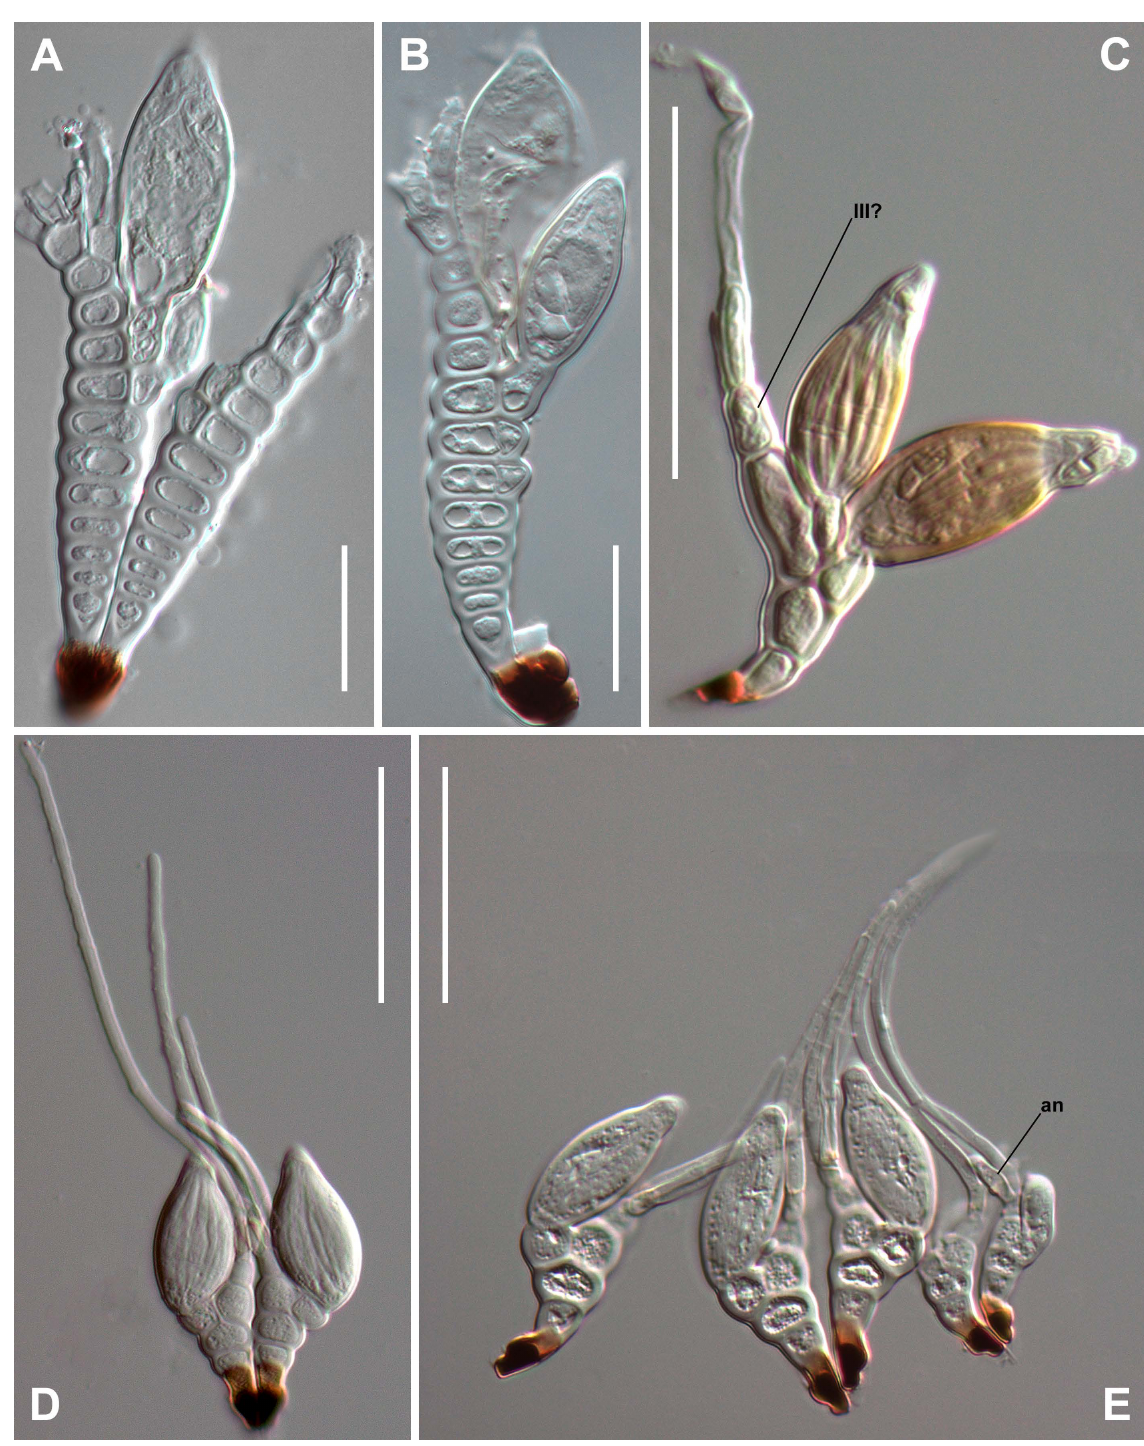
Fig. 11. A – B . Euphoriomyces unilateralis T.Majewski. A . Paired thalli. B . Thallus with two perithecia, the lower immature, the upper overmature. – C . Phaulomyces euaestheti (Thaxt.) I.I.Tav., mature thallus with two perithecia and with the probable cell III labelled (III?). – D – E . Phaulomyces octotemni (T.Majewski) I.I.Tav. D . Paired thalli. E . Five thalli with a labelled antheridium (an) on the right immature thallus. Scale bars: A–B = 20 µm; C–E = 50 µm. Photographs from slides ZMUC C-F-123798 (A–B), ZMUC C-F-122484 (C), ZMUC C-F-124330 (D), ZMUC C-F-124329